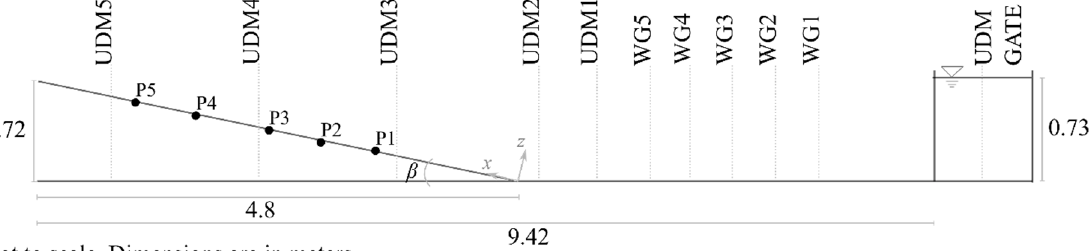
Figure 2. Schematic of the Center for Applied Coastal Research (CACR) flume located at the University of Delaware (Newark, NJ, USA) with sensor configurations and object deployment positions outlined.